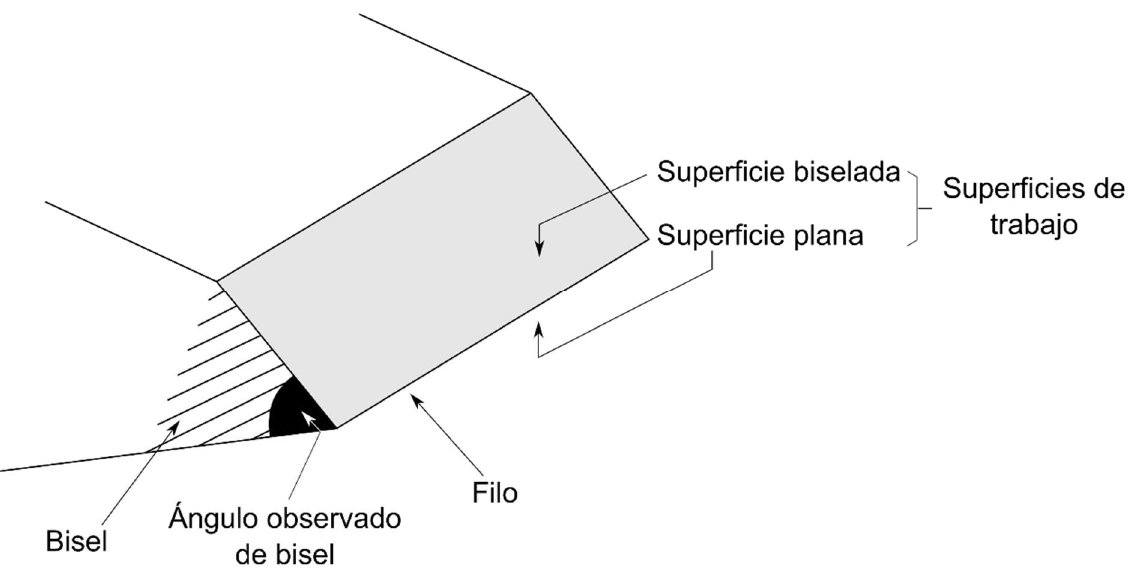
Figura 13. Términos utilizados para describir la geometría de la parte transformativa de un útil (modificado de Soriano et al.